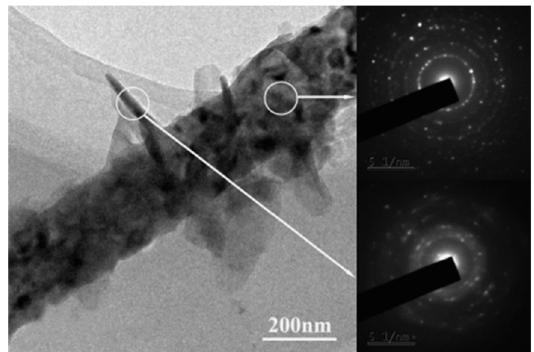
Figure 11. TEM image and electron diffraction patterns of selected areas of a TiO 2 /V 2 O 5 composite